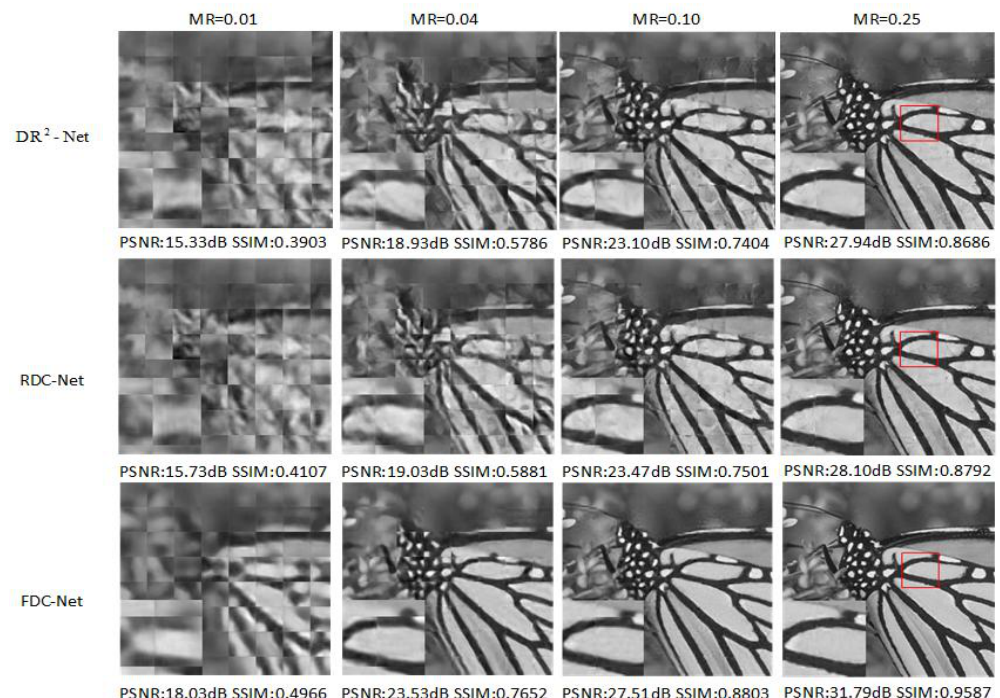
Figure 5. Monarch image reconstruction results from different networks. We can obviously find that two proposed networks obtain the excellent reconstruction performance and FDC-Net has better visual effects than RDC-Net, DR 2